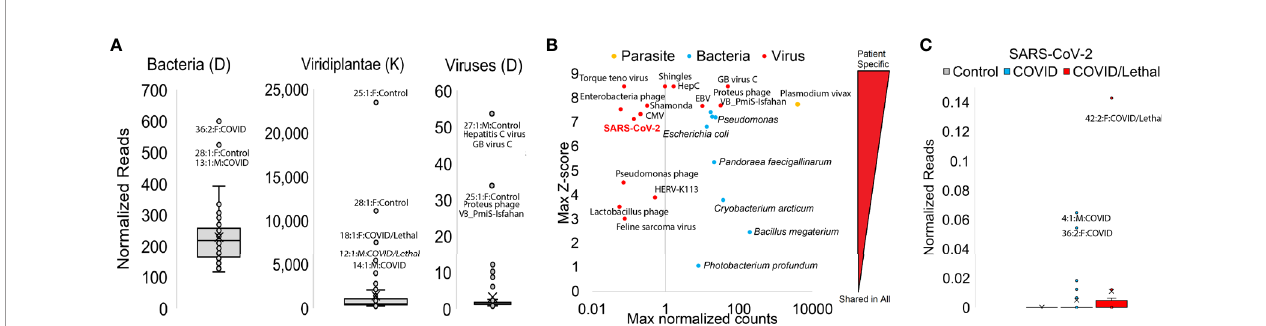
FIGURE 6 | Blood transcriptome foreign RNA signatures of SARS-CoV-2 patients. (A) Box and whisker plots for normalized reads mapped to bacteria, plants (Viridiplantae), or viruses with outlier samples labeled. (B) Top mapping values in samples for parasite (orange), bacteria (cyan), or virus (red) RNA. Values are shown as the highest (max) sample normalized counts (x-axis) for each labeled vs. the z-score for that sample (y-axis) relative to the entire cohort. (C) Box and whisker plot for normalized SARS-CoV-2 reads. Controls are gray, COVID samples cyan, and COVID/Lethal red.